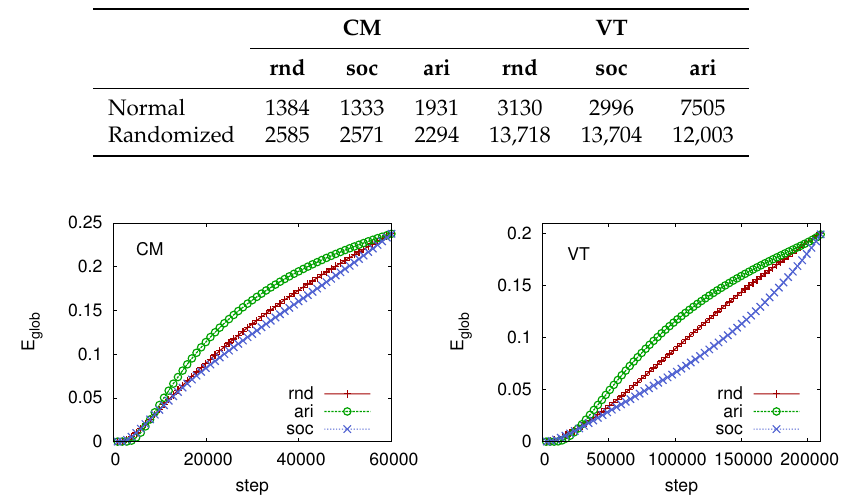
Figure 7. Effect of serial network simulation for Communities ( left panel ) and VirtualTourist ( right panel ). After an initial time span (approximately one sixth of the entire simulation time), the preferential attachment rule (aristocratic) outperforms the